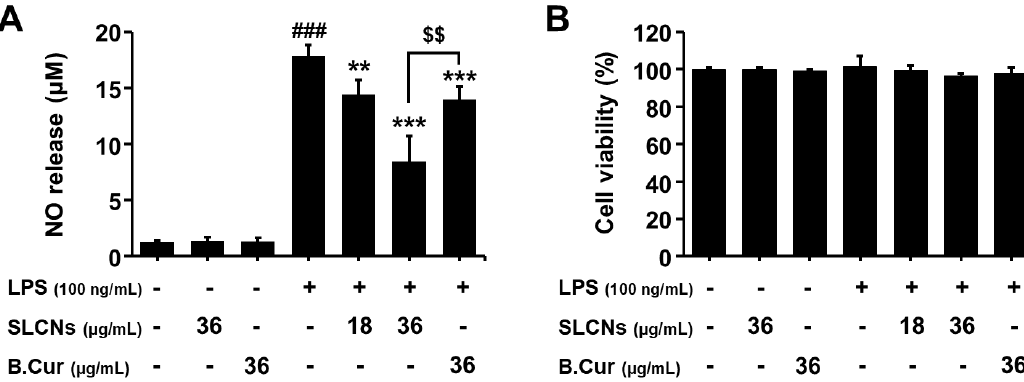
Figure 3. Effect of SLCN and base curcumin on NO production and cell viability in lipopolysaccharide LPS-stimulated BV2 cells. BV2 cells were pretreated with the indicated concentrations (18 and 36 µg/mL) of SLCN and base curcumin (B.Cur) for 1 h before incubation with LPS (100 ng/mL) for 24 h. Nitrite was measured using the Griess reaction ( A ). The cell viability was evaluated using the MTT assay ( B ). Results are displayed as a percentage of untreated groups. ### p < 0.001, vs. untreated group; ** p < 0.01 and *** p < 0.001 vs. LPS-treated group; $$ p < 0.01 vs. SLCN-treated group (one-way ANOVA; n = 4).